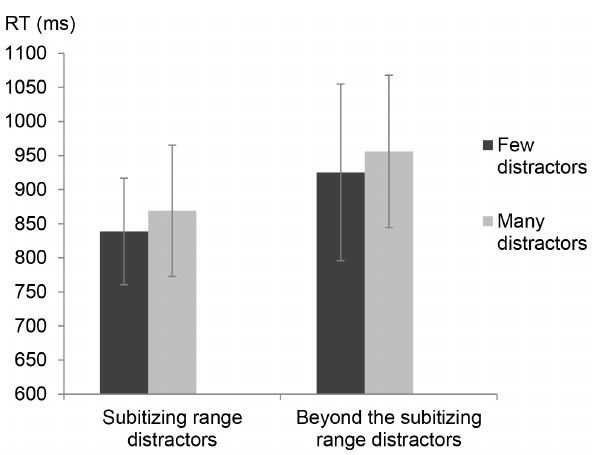
Figure 3. Mean RT and SD for counting subset items in the various conditions in Experiment